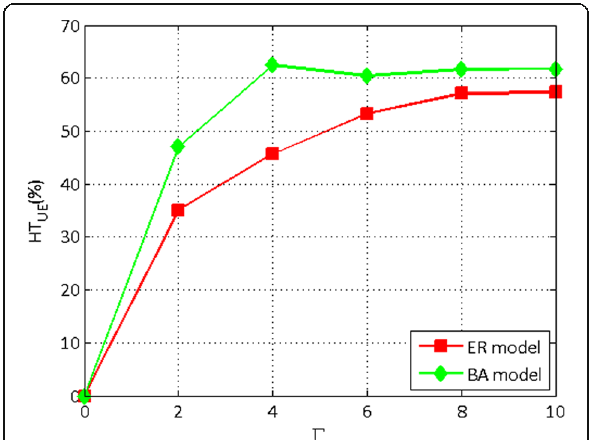
(cid:3) Fig. 17 Impact of T SBS T UE to hit rate in the SBS level in ER model ( d UE ¼ 4 ; N UE ¼ 60 ; Γ ¼ 6)